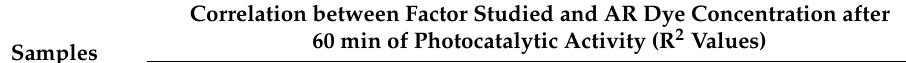
Table 9. Correlation (R 2 Values) between factor studied and AR dye concentration after 60 min of photocatalytic activity (R 2